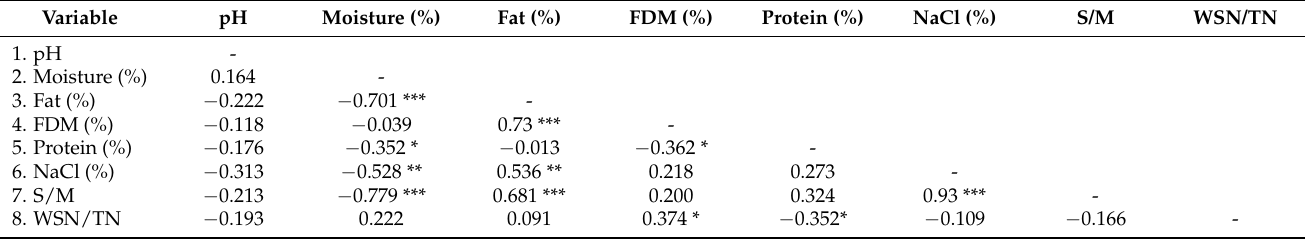
Table 4. Pearson correlation coefficients between physicochemical parameters for pasteurized cheese.